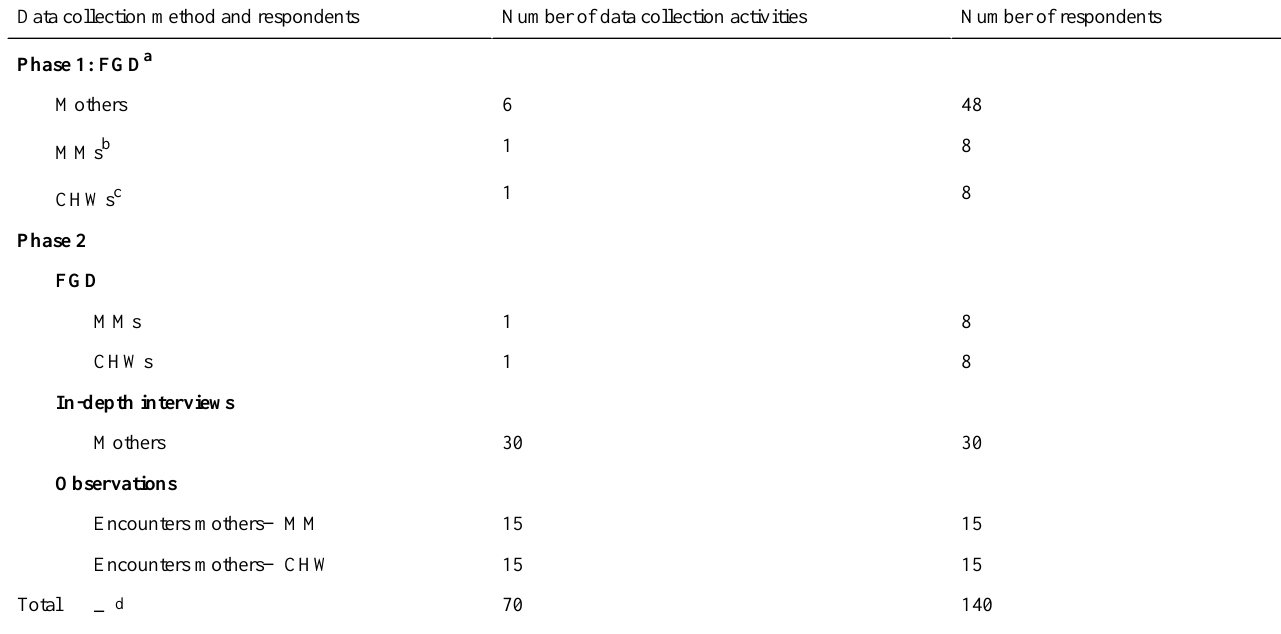
Table 2. Respondent groups by data collection method.